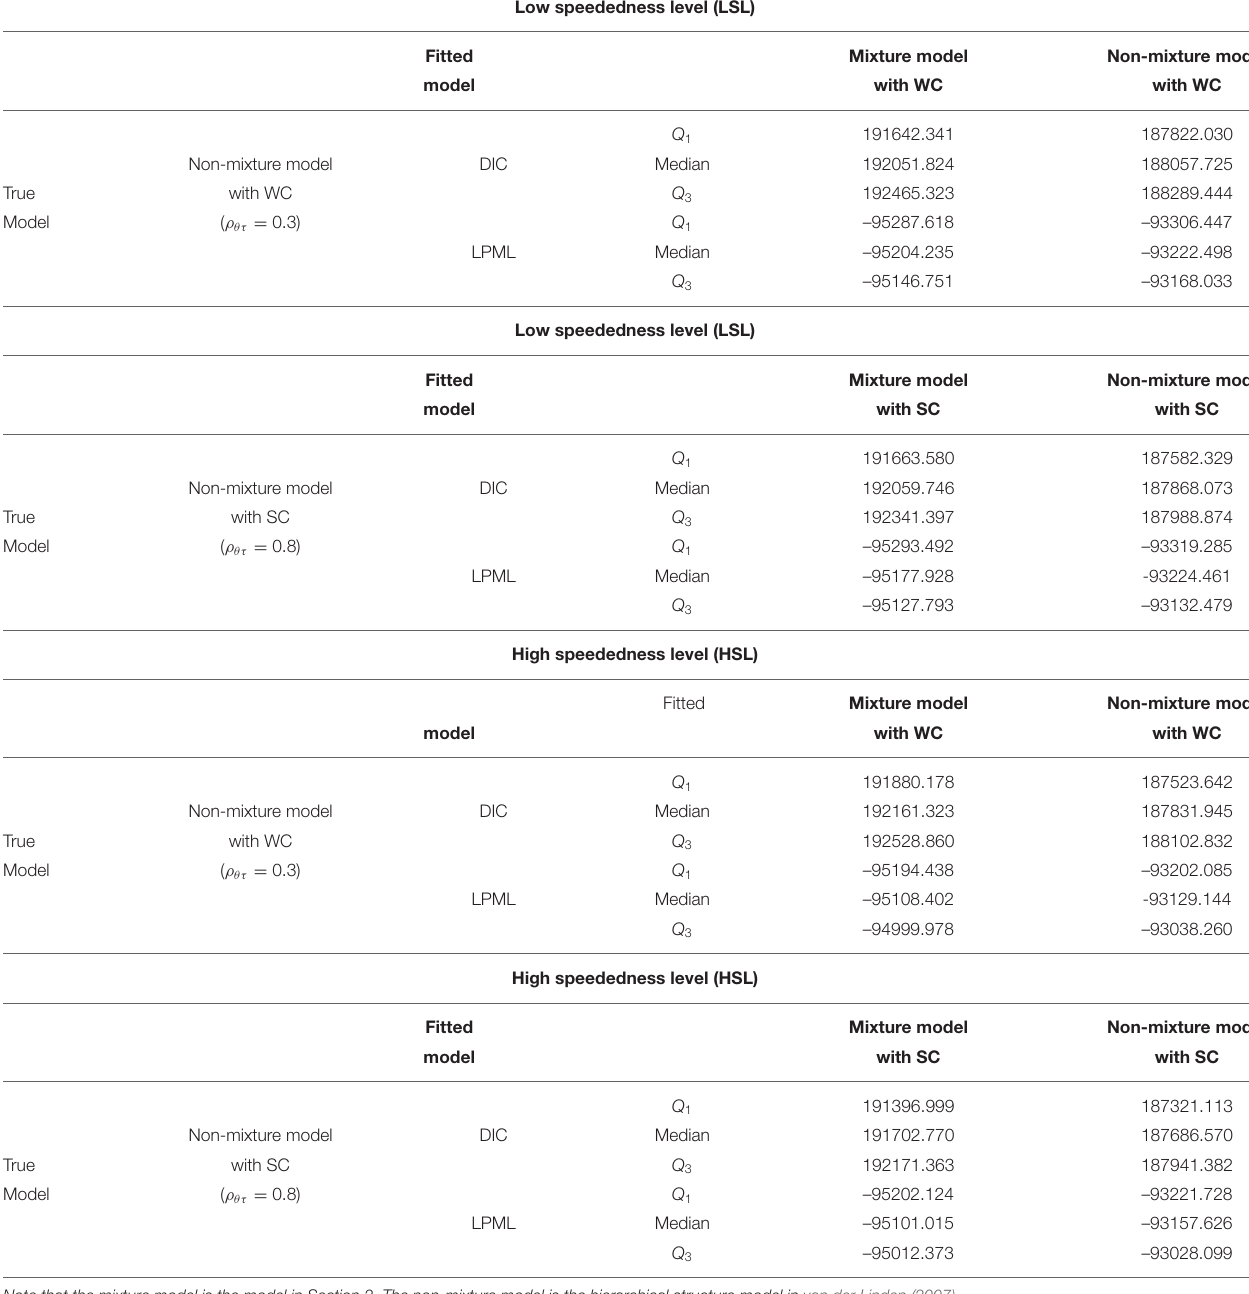
TABLE 4 | The results of Bayesian model assessment in simulation study